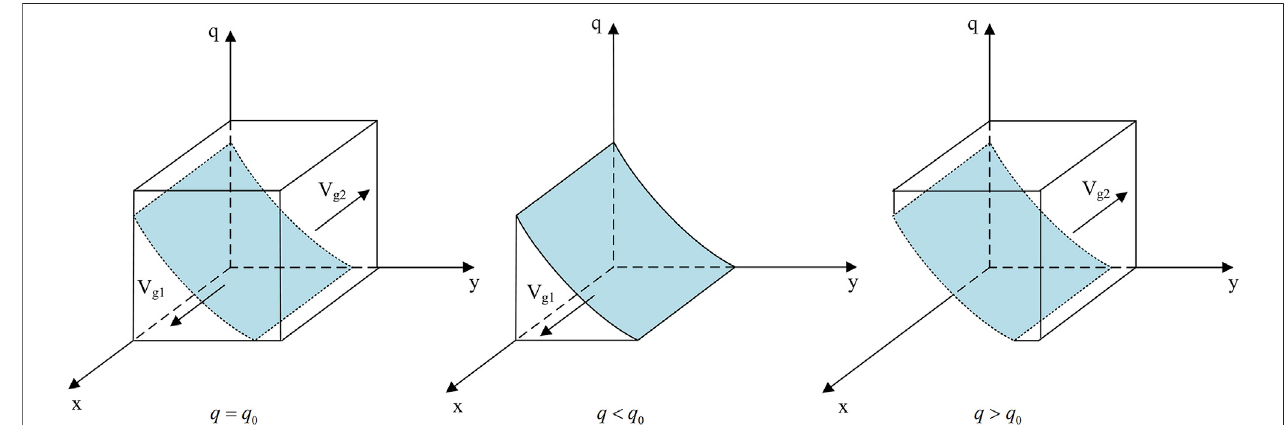
FIGURE 2 | The strategic choices of governmental supervision